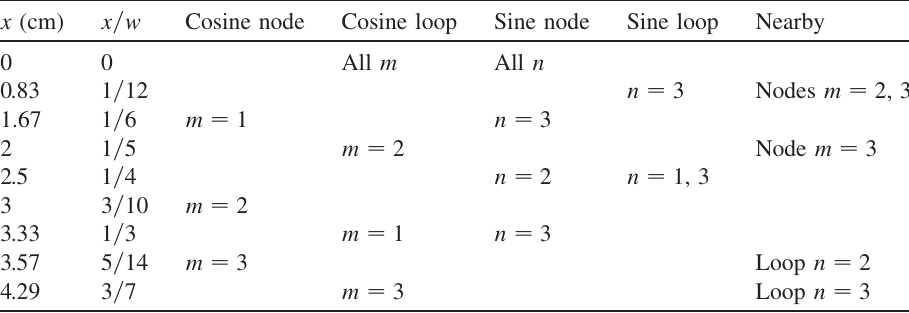
TABLE I. Nodes and loops of grating with sidewalls.